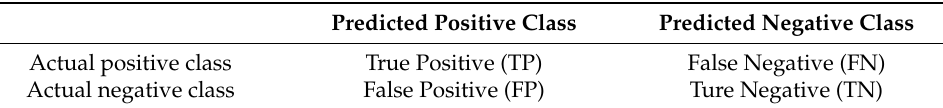
Table 2. The confusion matrix, including four basic